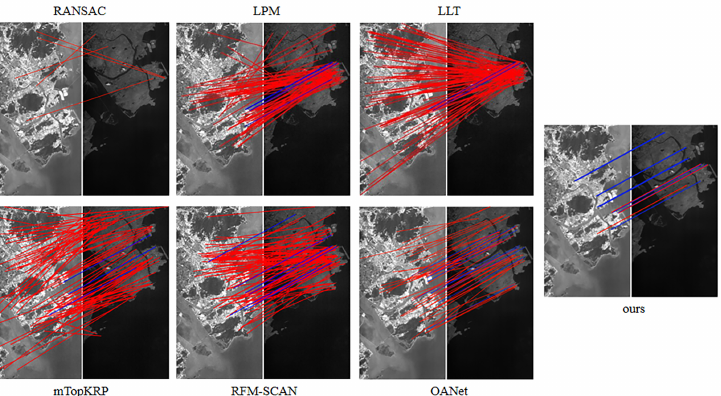
Figure 10. Comparison of seven feature matching methods. The points connected by line segments are the inliers. Blue indicates true positives, and red indicates false positives.